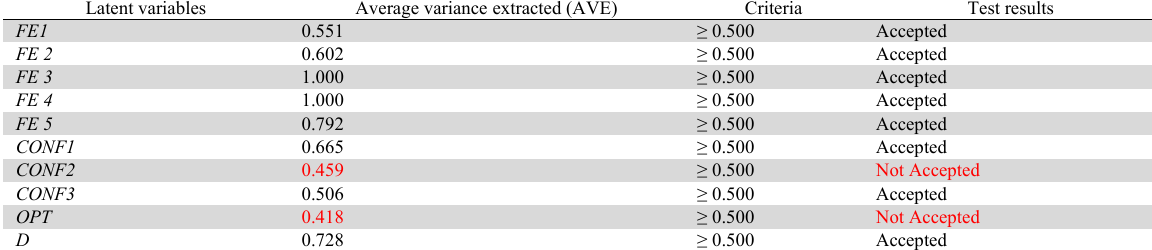
Summary of Statistical Measurements of Average Variance Extracted (AVE) Scores (Model I) Latent variables Average variance extracted